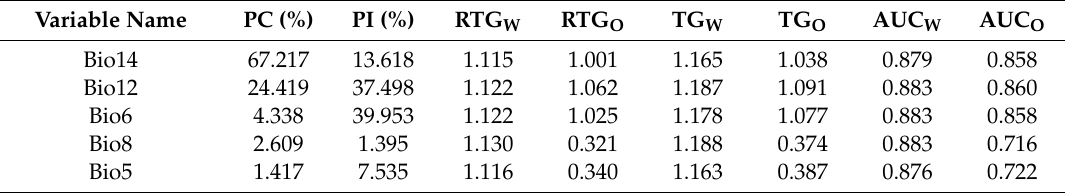
Table 3. Contribution (i.e., important) parameters of the five climate variables included in the optimal